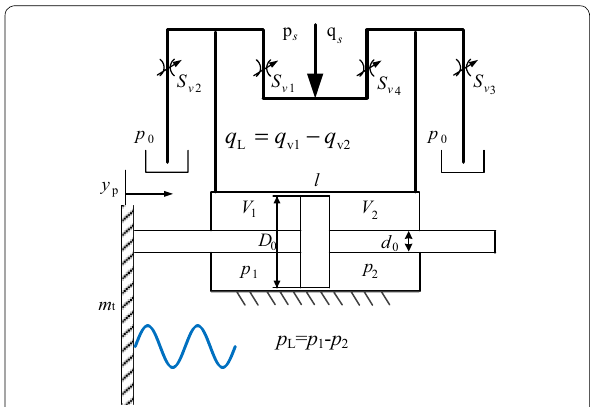
Figure 4 Equivalent bridge of the rotary valve-controlled cylinder